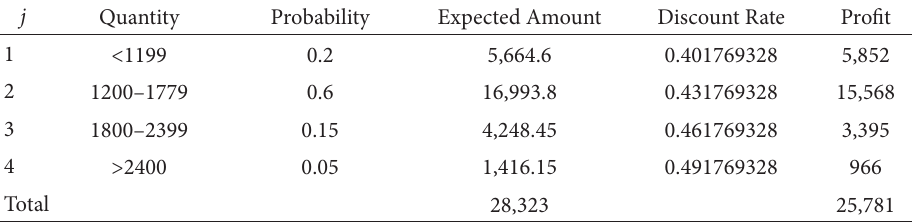
Table 7. Probabilities of the intervals and final discount rates of vendor 0345 for DS2 .